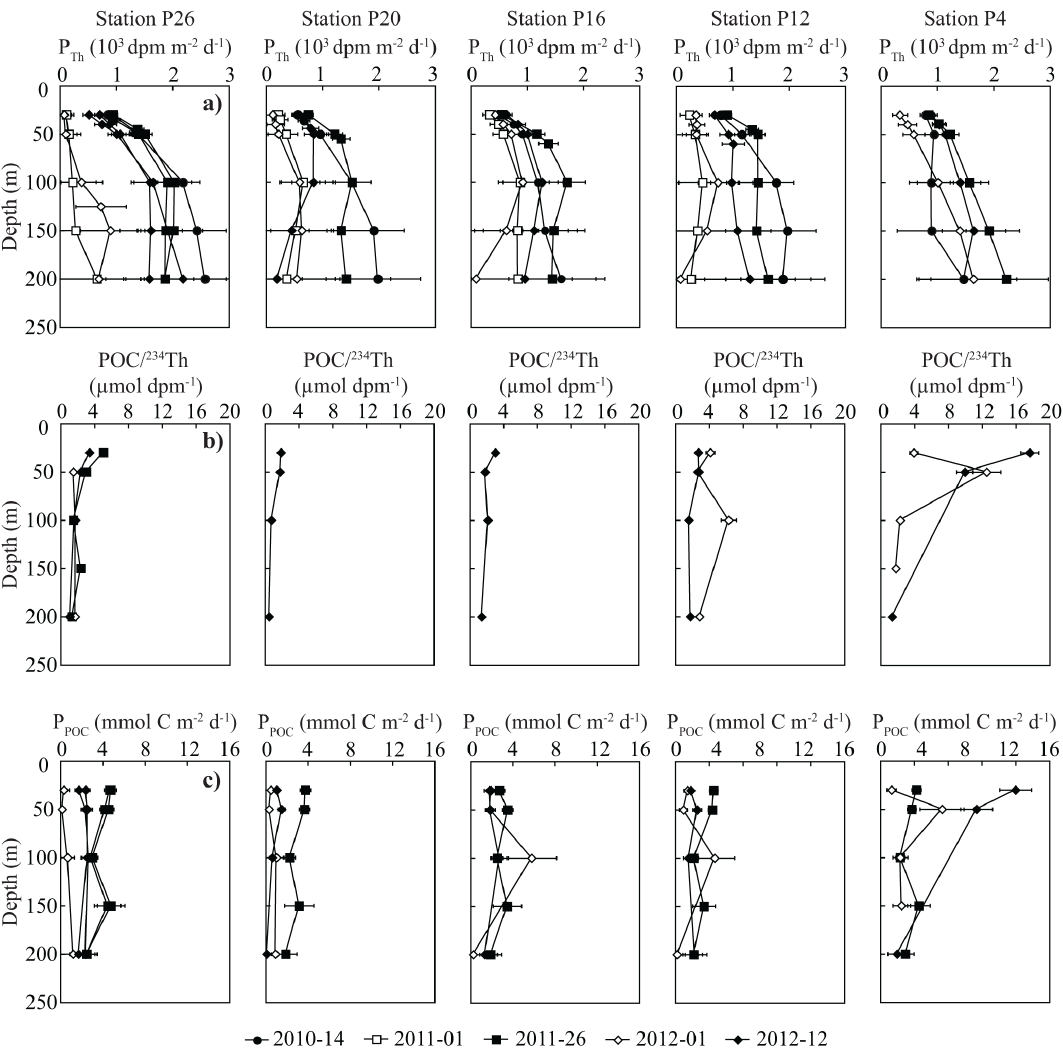
Figure 9. Depth profiles of (a) 234 Th fluxes ( P Th ) determined using the 2-D model, (b) POC / 234 Th ratios on > 53µm particles, and (c) 234 Th-derived POC fluxes ( P POC ) at stations on Line P during the five cruises in this